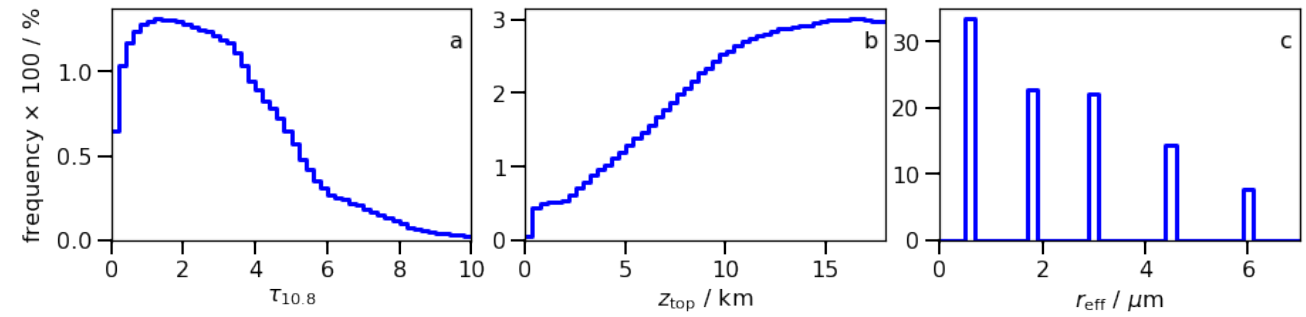
Figure 12. Distributions of: ( a ) τ 10.8 in Training A ; ( b ) z top in Training B ; ( c ) r eff in Training B . In ( a ), only non-zero values are